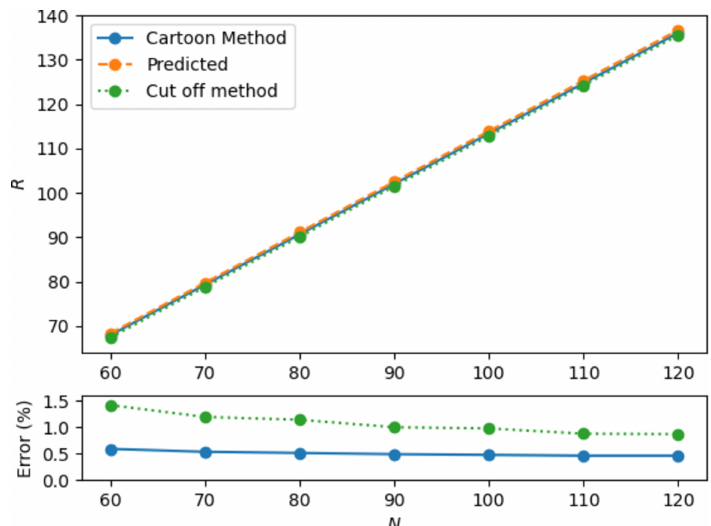
Figure 30 . A comparison of the radii of vortons produced by gradient flow using the cut off method and the cartoon method in parameter set B with Q/N = 31 . 89 kept constant. The predicted radii from the thin string analysis has also been displayed. The cartoon method is in better agreement with the predicted radii than the cut off method. Both of the percentage error plots decrease with N , with the cut off method approaching the accuracy of the cartoon method at larger